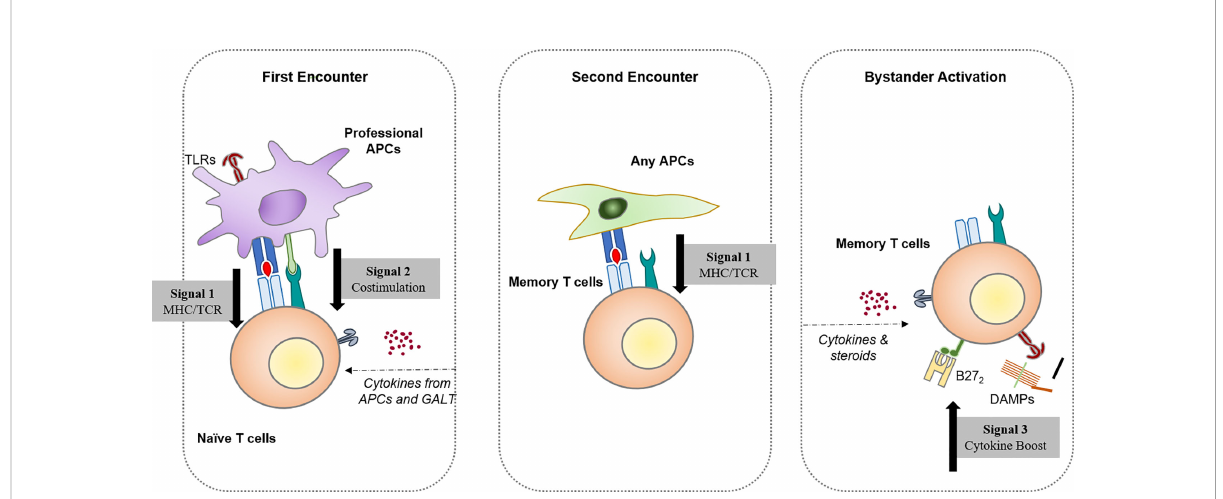
FIGURE 1 Three different ways resting/naïve T lymphocytes become activated. Activation by the fi rst encounter requires naïve lymphocytes associated with professional antigen-presenting cells, namely, dendritic cells. The second encounter with the antigen is enough to generate a fast, strong response for memory lymphocytes in the resting state. Hypotheses based on the canonical fi rst/second encounter models led to an exploration of potential cross-reactive antigens that elicit spondyloarthritis after pathogen infection. With improved knowledge of the immune regulatory network, the antigen-independent activation of T cells has been identi fi ed, which provides a possible pathway for autoreactive T cells that bypasses central tolerogenesis